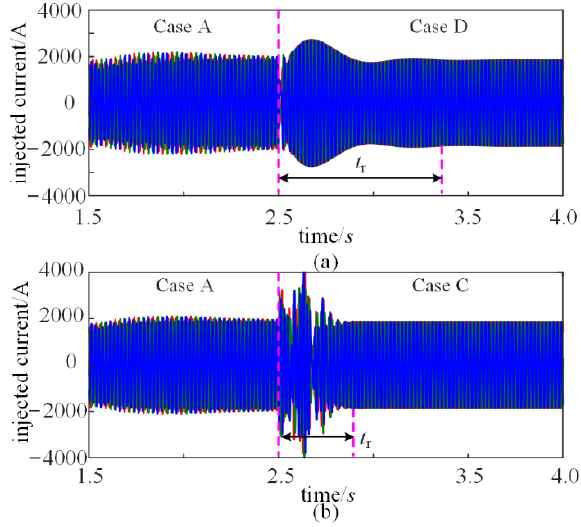
Figure 13. ( a ) Waveform of injected current of the MMC-HVDC integrated system from Case A to Case D. ( b ) Waveform of injected current of the MMC-HVDC integrated system from Case A to Case C.